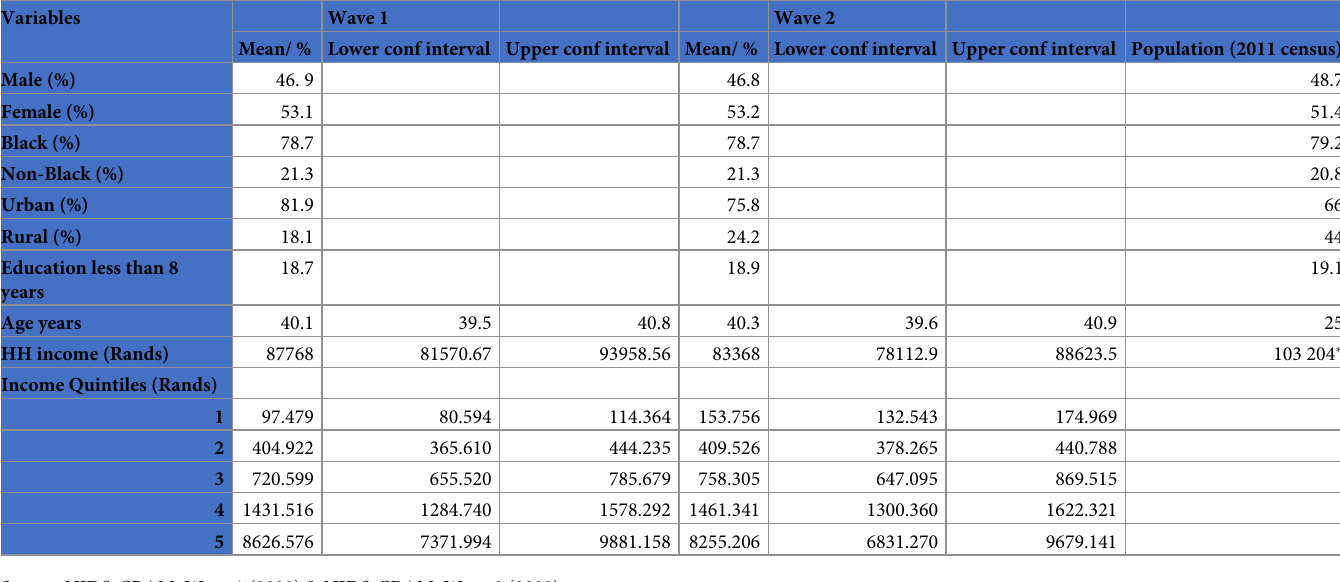
Table 1. Descriptive statistics of the key socio-economic